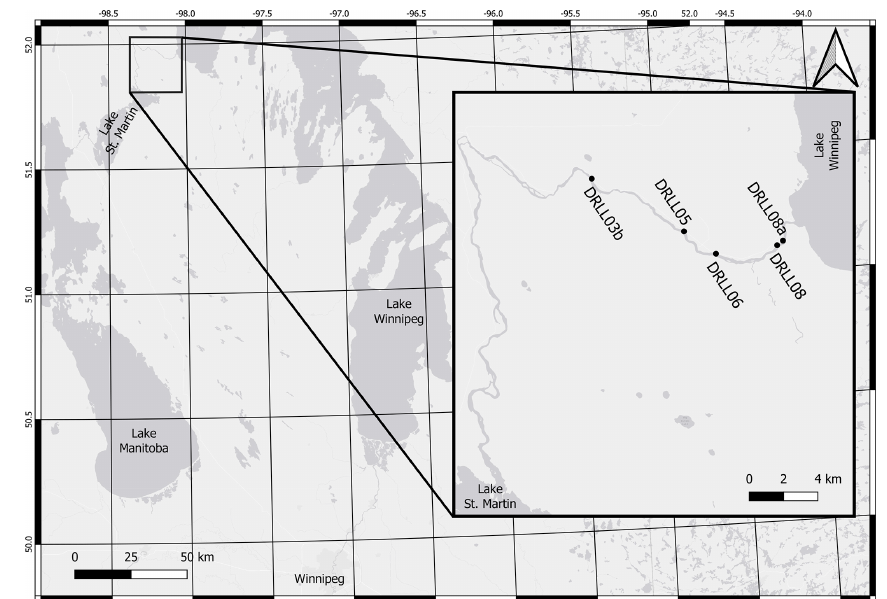
Figure 1. Key map of the study